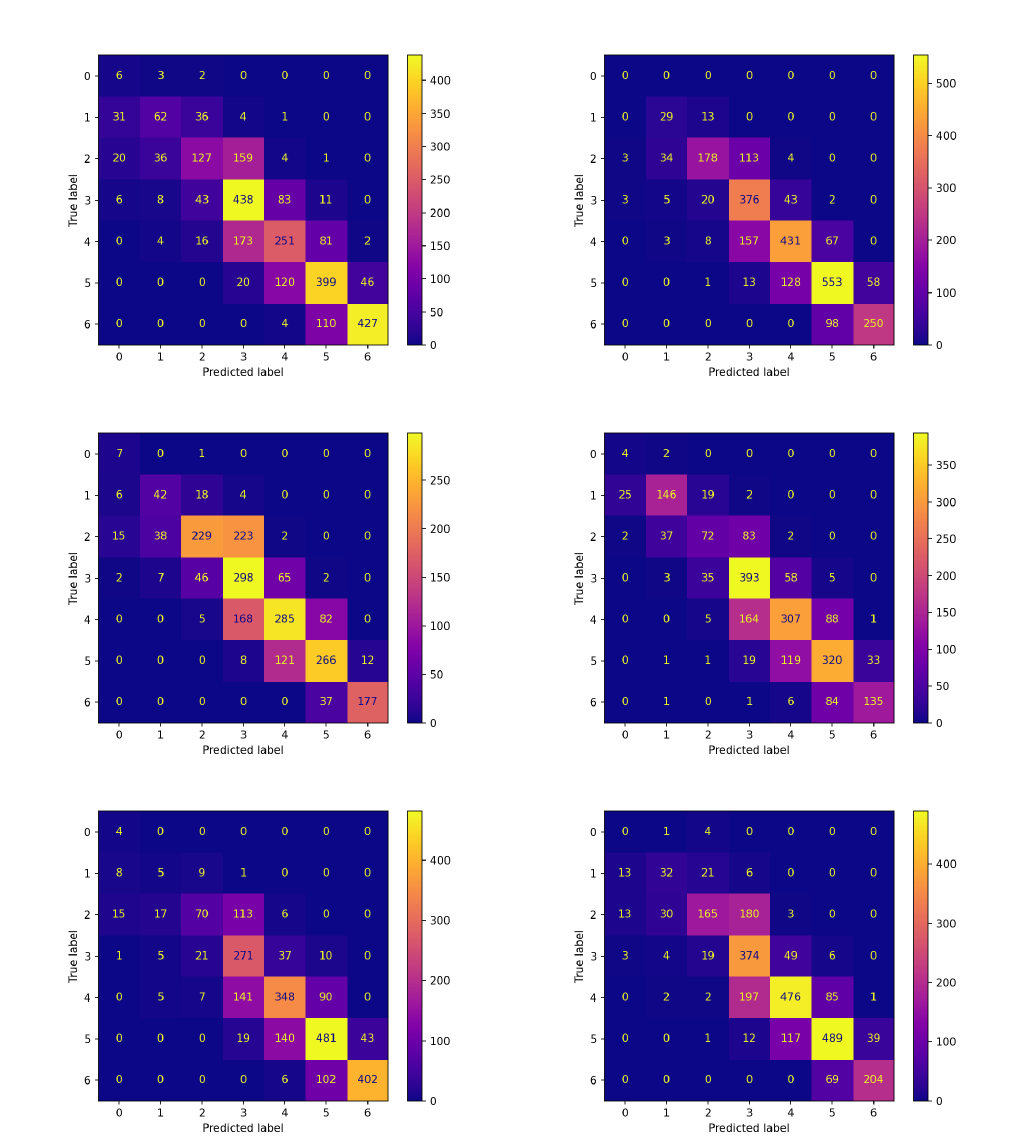
Figure 7. Confusion matrices on the testing set of new subjects not participating in the learning process achieved by the best model (model 575) evolved by FLEA